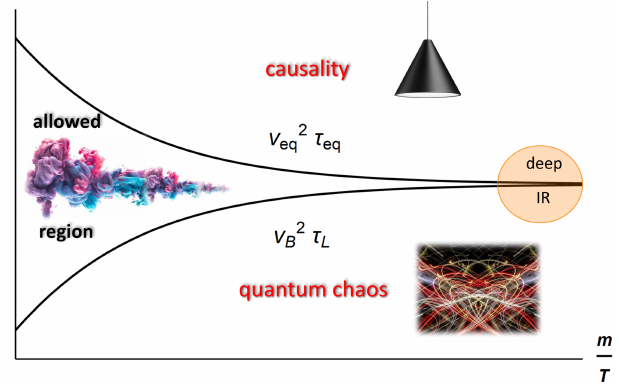
Figure 7 . A cartoon of the allowed region for the diffusion constant D . The upper edge comes from the scales related to the breakdown of linearized hydrodynamics. While, the lower one is dictated by the data of quantum chaos [34]. Both curves merge in the limit of T → 0